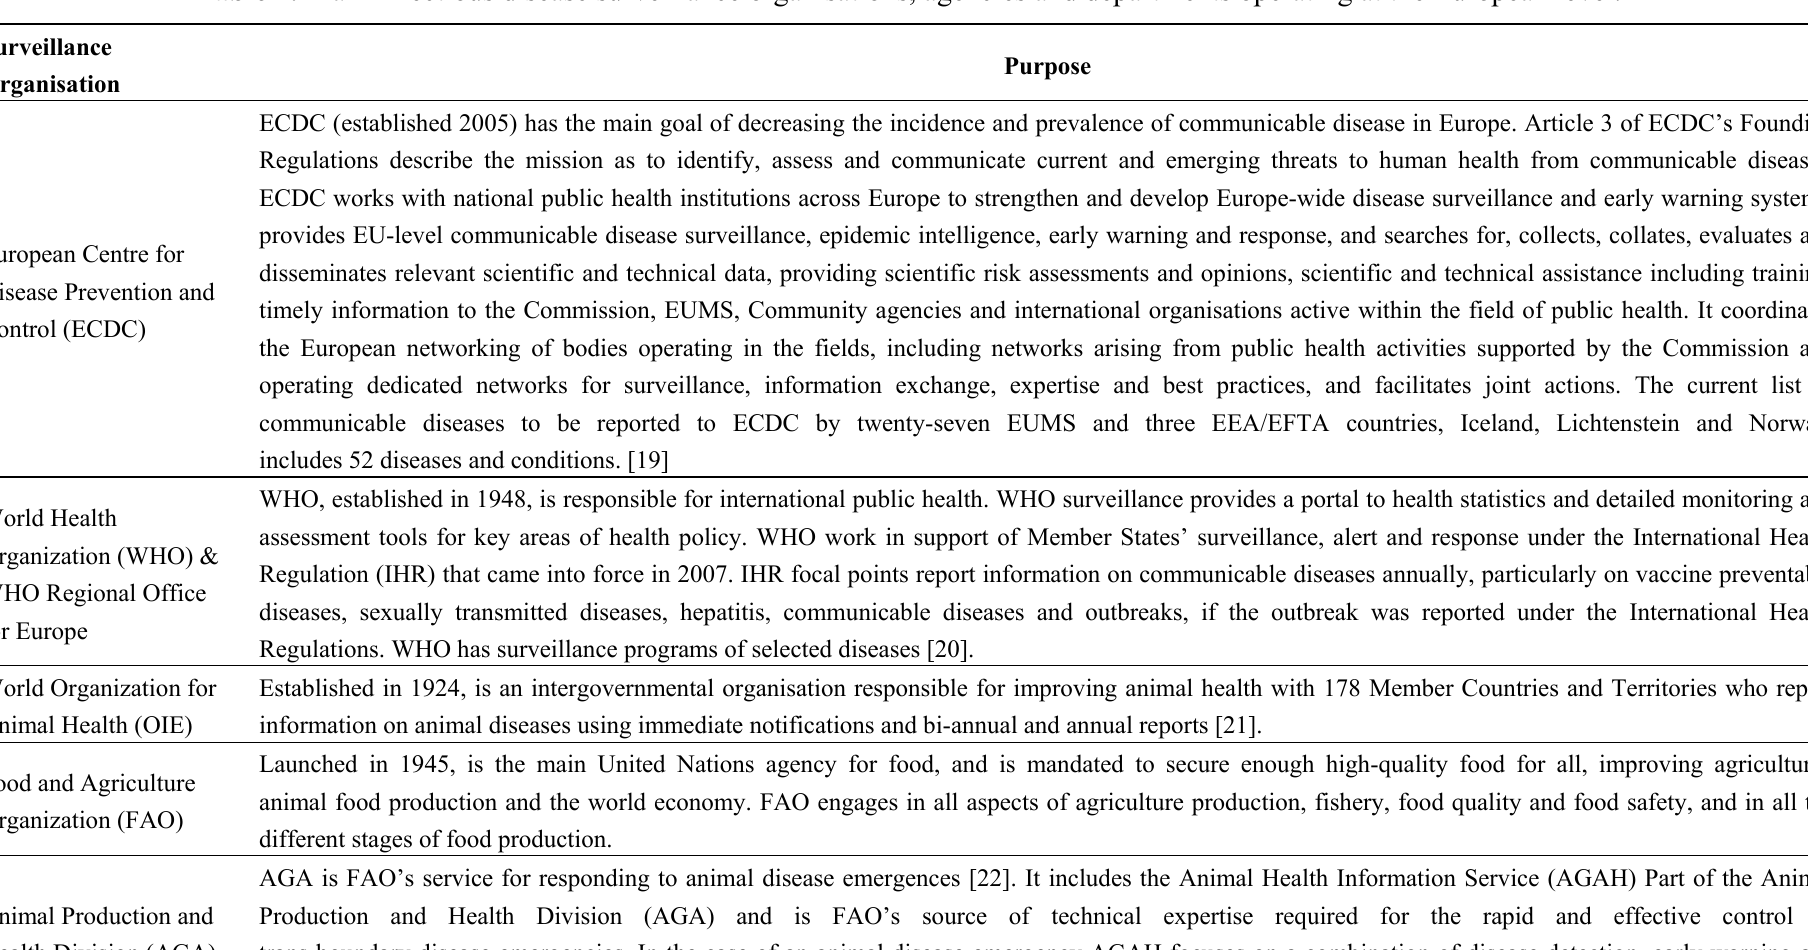
Table 1. Main infectious disease surveillance organisations, agencies and departments operating at the European